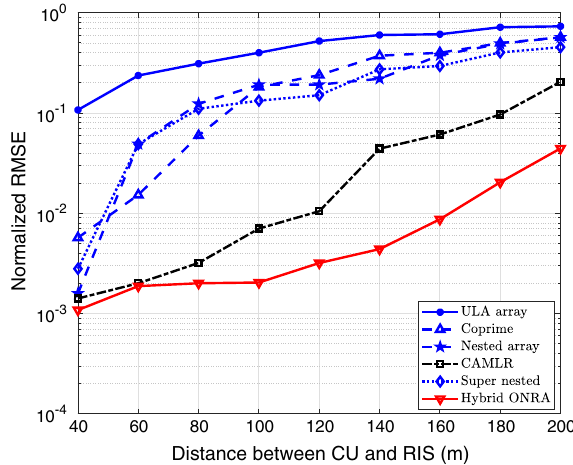
Fig. 8 RMSE of the CU-RIS channel versus the distance between CU and RIS (Transmit power